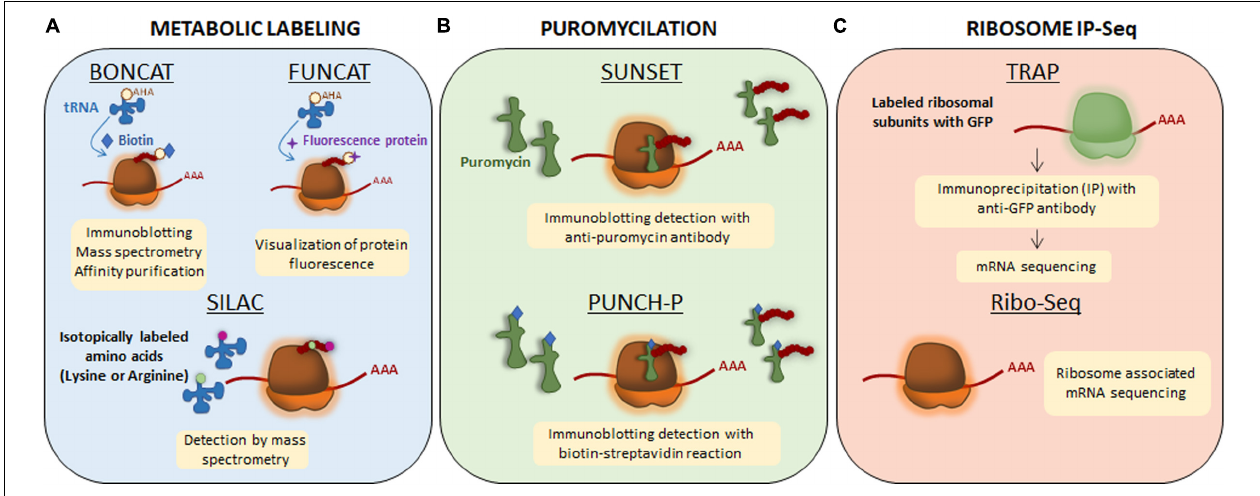
FIGURE 2 | Techniques to detect newly synthesized proteins. (A) Metabolic labeling. Bioorthogonal non-canonical amino acid tagging (BONCAT) and fluorescent non-canonical amino acid techniques (FUNCAT) are based on non-canonical methionine derivates (an azide or an alkaline) and therefore, they are able to get incorporated to the nascent protein as methionine through endogenous methyionil-transfer RNA (tRNA) synthetase. The newly synthesized proteins will be labeled with azide or alkyne groups. For their detection, exogenous reactive groups are then incorporated to azide or alkyne groups: biotin in BONCAT and a fluorescence protein in FUNCAT. For stable isotope labeling using amino acids in cell culture (SILAC), lysine and arginine are isotopically labeled with 12 C (light amino acids) and 13 C (heavy amino acids). The incorporation of labeled amino acids allows them to enter into newly synthesized proteins and be detected by mass spectrometry. (B) Puromycilation. Puromycin is an antibiotic that structurally mimics tRNAs so it can get incorporated into the nascent polypeptide chain and elongation is stopped. Puromycilated-proteins can be detected by immunochemistry directly using an anti-puromycin antibody for surface sensing of translation technique (SUNSET) or indirectly when puromycin is bound to biotin for puromycin-associated nascent chain proteomics (PUNCH-P). (C) Ribosome immunoprecipitation-sequencing (IP-Seq). Translating ribosome affinity purification (TRAP) method consists on labeling ribosomal subunits with Green Fluorescence Protein (GFP) followed by immunoprecipitation approach. Transcripts bound to ribosomes containing GFP will be isolated and sequenced by RNA-sequencing. Ribo-Seq technique is based on sequencing all mRNA transcripts which are associated to